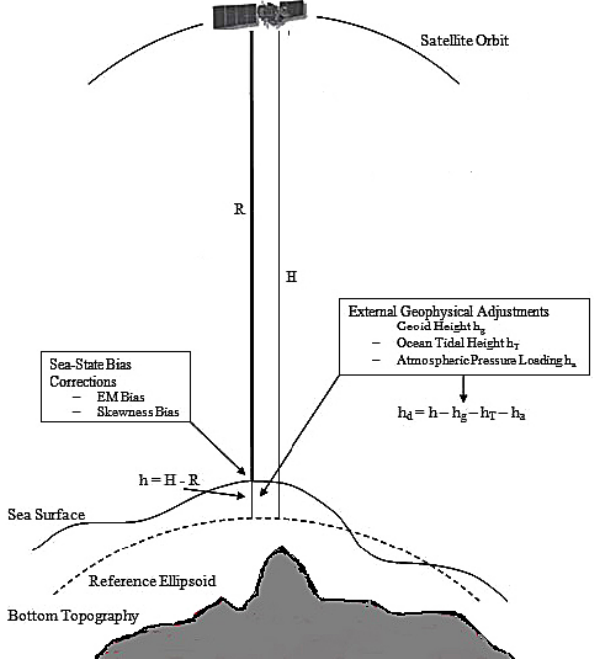
Figure 3. An illustration of height measurement using satellite al-